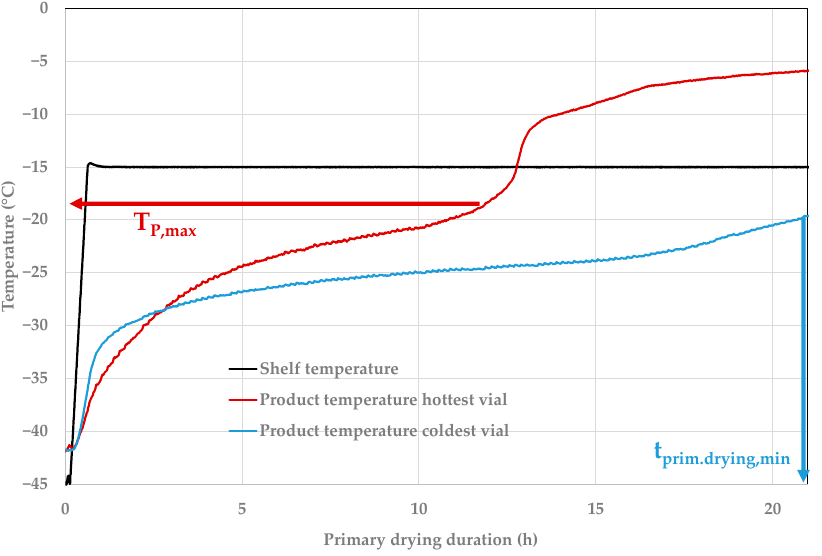
Figure 2. Exemplified product temperature profiles for the hottest and coldest vial [21].